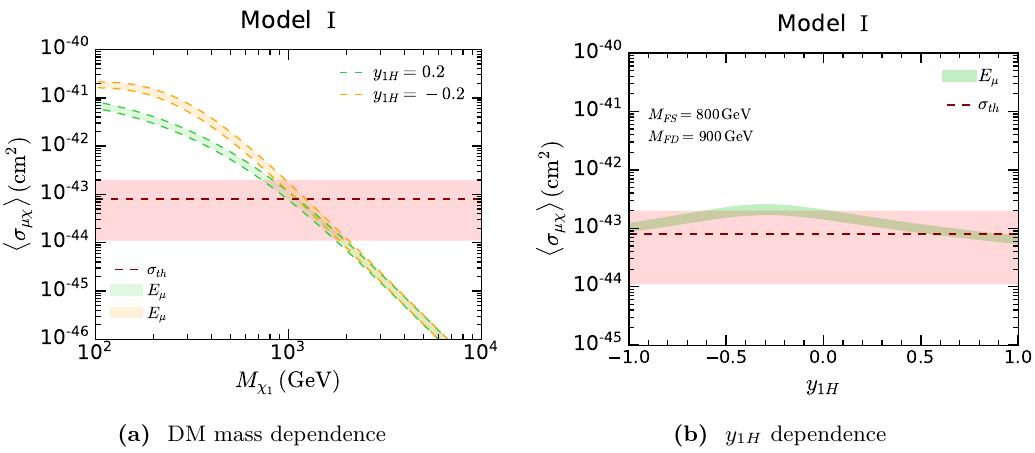
Figure 5. The DM-muon scattering cross sections as functions of (a) the DM mass M χ (b) y 1 H . The rest of the parameters are fixed as per in figure 2. E µ is varied in the range [ m µ , m µ / B ( R NS )] for M NS = 1 . 5 M (cid:12) and R NS = 12 . 593 km and the resultant change in the cross section is indicated by the band. The horizontal red dashed line shows the threshold cross section p for muon, σ th ’ 8 × 10 − 44 cm 2 and the horizontal red band represents the variation of the threshold cross section due to the EoS uncertainty [129].